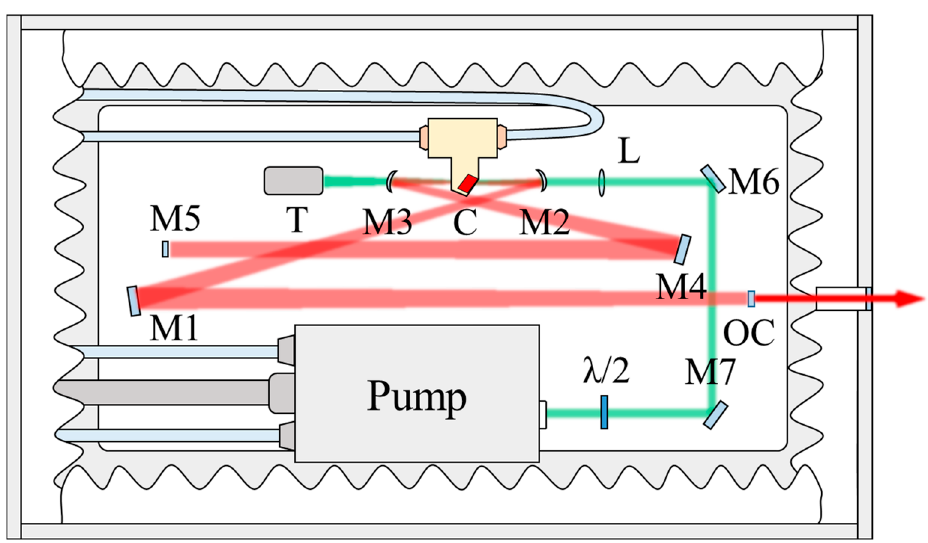
Figure 1. Schematic diagram of one laser. λ /2: half-wave plate. M2, M3: concave chirped mirror pairs. M1, M4: plane chirped mirror pairs. M5: silver mirror, mounted on a piezoelectric transducer. M6, M7: high reflector at 532 nm. OC: output coupler. C: Ti:sapphire crystal. L: coupling lens with 75 mm focal length. D: beam dump.